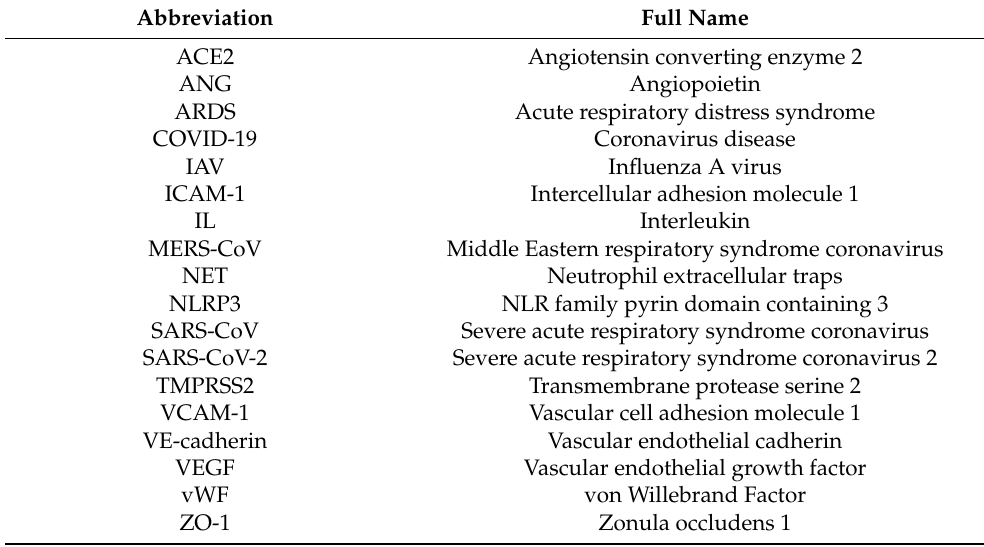
Figure 1. Influenza A compared to severe acute respiratory syndrome coronavirus 2 (SARS-CoV-2) infection. ( A ). On the left, infection with influenza A virus is illustrated, while SARS-CoV-2 is depicted on the right. Alveolar epithelial and endothelial cells are infected leading to proinflammatory cytokine production, recruitment of neutrophils and cell death by neutrophil extracellular traps (NETosis), activation of platelets and formation of thrombi, loss of junctional integrity and edema. ( B ). Binding of avian influenza and human influenza to their respective sialic acid linked receptors on endothelial cells. Lung endothelial infection by H3N2/H1N1 has been observed mostly in vitro and its true incidence during in vivo infections is uncertain. ( C ). Binding of SARS-CoV-2 to ACE-2 (angiotensin converting enzyme 2), its receptor, on an endothelial cell. Spike protein undergoes priming by transmembrane protease serine 2 (TMPRSS2) prior to internalization. Table 1. Abbreviations frequently used in this